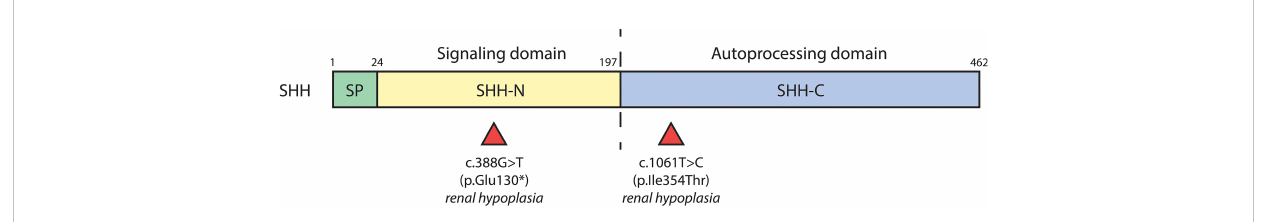
FIGURE 3 SHH variants associated with CAKUT. Schematic diagram of the biochemical domains of human SHH shows the signal peptide (SP, a.a. 1-23), signaling domain (SHH-N, a.a. 24-197), and autoprocessing domain (SHH-C, a.a. 198-462). The dashed line indicates the site of autocatalytic cleavage. Red triangles underneath denote location of SHH variants and their associated renal phenotypes.